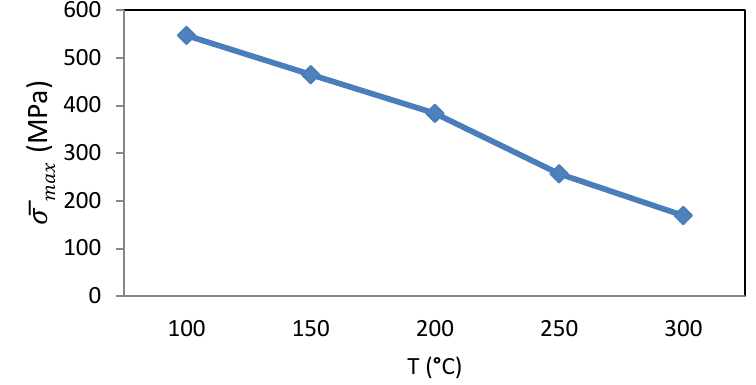
Figure 12. Influence of the temperature on the core maximum effective stress.